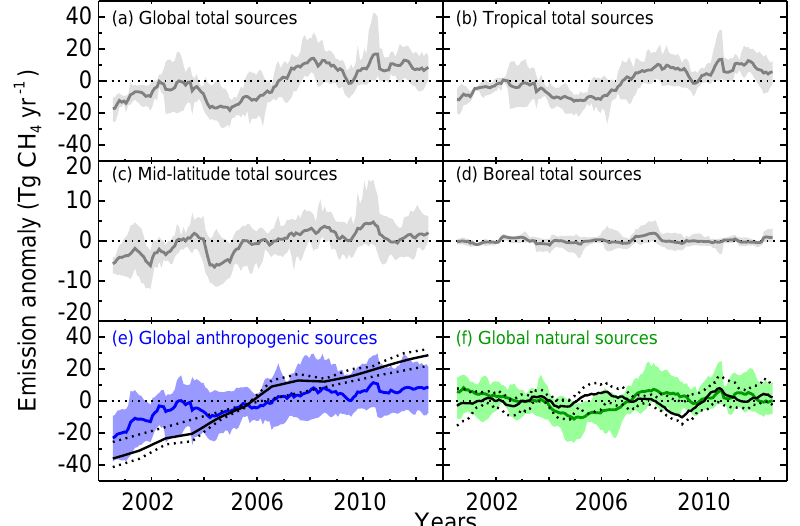
Figure 2. The 12-month running mean of annual methane emission anomalies (inTg CH 4 yr − 1 ) inferred by the ensemble of inversions (mean as the solid line and min–max range as the shaded area) in grey for (a) global, (b) tropical, (c) mid-latitudes, and (d) boreal total sources; in blue for (e) global anthropogenic sources; and in green for (f) natural sources. The solid and dotted black lines represent the mean and min–max range (respectively) of the bottom-up estimates: anthropogenic inventories in (e) and ensemble of wetland models in (f) . The vertical scale is divided by 2 for the mid-latitude and boreal regions.